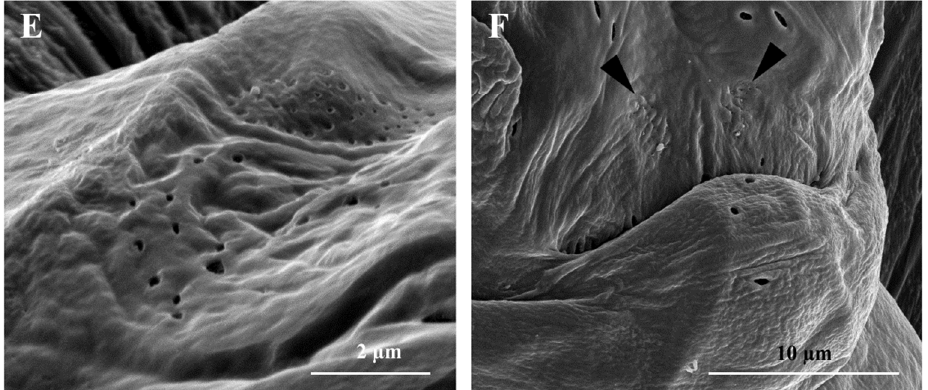
Figure 3. Macrobiotus kyoukenus sp. nov. ( A ) Third pair of legs with claws and a flat bulge (arrow- head); ( B ) Fourth pair of legs ornamented with cuticular granules (arrows) and with claws and a flat bulge (arrowhead); ( C ) Antero-lateral sensory field (ALS) with small pores on the side of the mouth (arrowhead); ( D ) Postero-lateral sensory field (PLS) with small pores on the side of the head (arrowhead); ( E ) Postero-lateral sensory field with small pores on the side of the head (enlargement of d); ( F ) Cloaca sensory fields with small pores (arrowheads). ( A – F ) SEM.